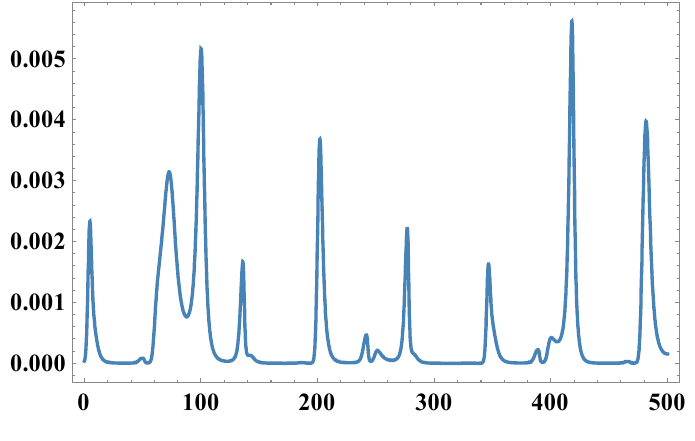
Figure 1. Time series of Det (M).